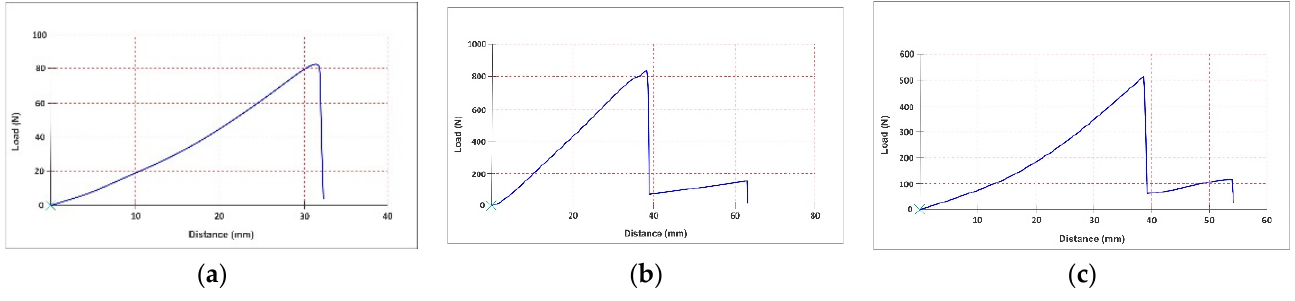
Figure 6. Tensile curve for unprocessed samples: ( a ) calfskin (M1); ( b ) calfskin with PES knitted fabric lining (M1 + M2); and ( c ) calfskin with sheep leather lining (M1 + M3).